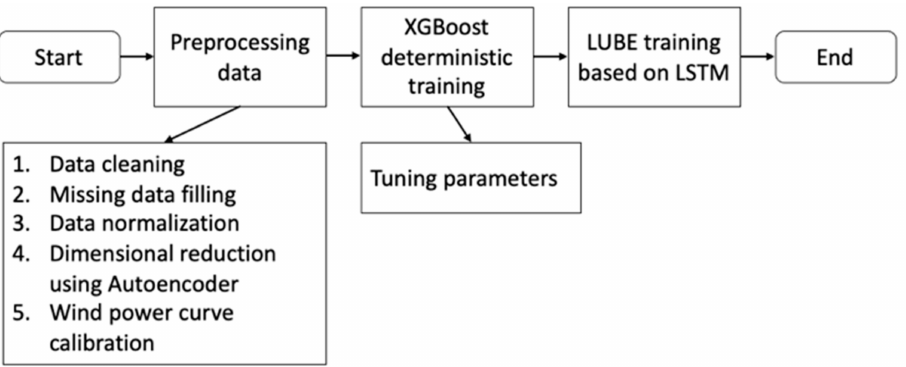
Figure 7. Block diagram of the proposed probabilistic forecasting. The outputs of the LUBE-LSTM model provide a lower bound and upper bound on wind power forecasts. Figure 8 depicts the overall steps of the proposed forecasting method. There are nine steps for the proposed forecasting method.